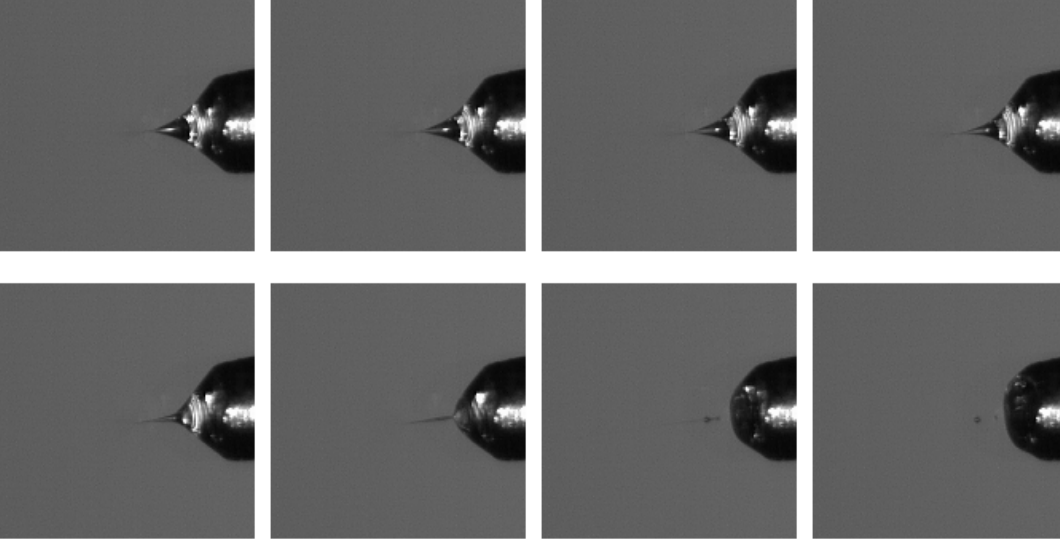
Figure 31. Formation and decay of the jet. Photographs are taken 0.1 ms apart. The experiment was done in setup II with solution a0 at 22.0 ◦ C and relative humidity 40%. Photographs were exported from the record of the Olympus i-SPEED 720 high-speed camera using i-SPEED Software Suite [52].